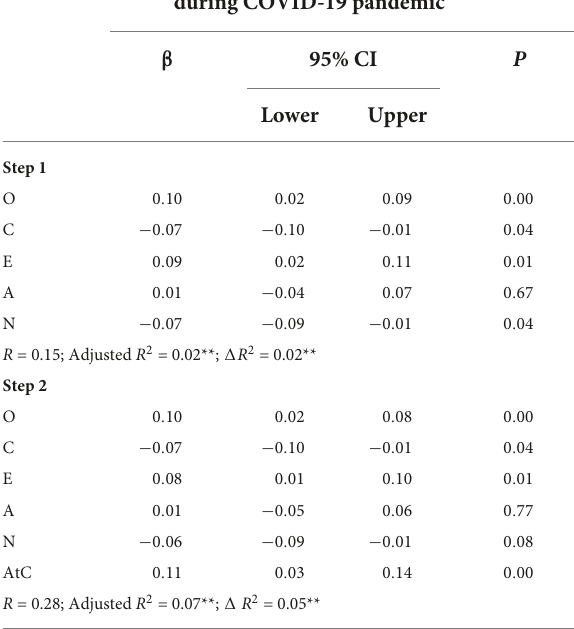
TABLE 2 Hierarchical multiple regression analysis for attitudes toward visiting hospitality facilities during COVID-19 pandemic.